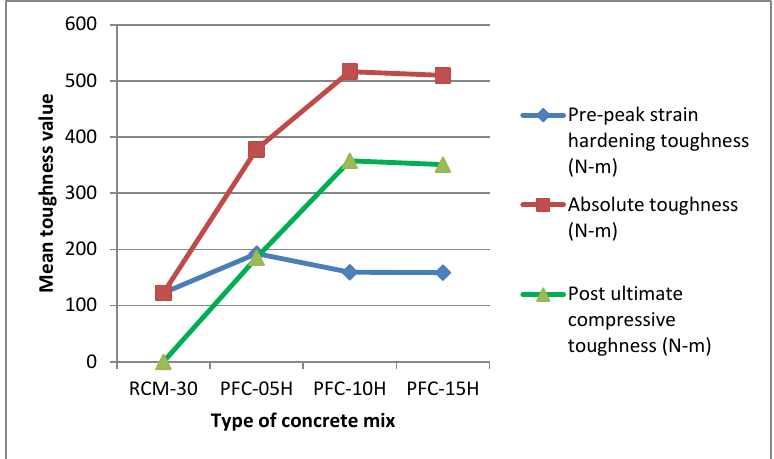
Figure 11. Mean compressive toughness performance values of various fiber concrete mixes.